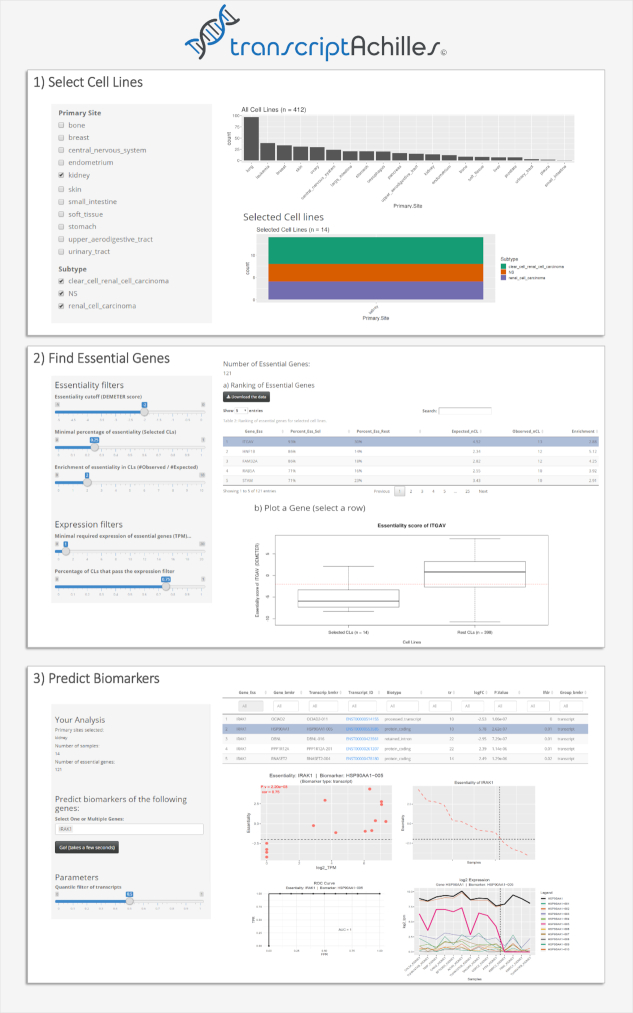
Screenshots of the 3 main tabs of TranscriptAchilles. (1) Selection of cell lines. Both primary site and subtypes can be selected. Two histograms summarize the number of all (up) and selected (down) cell lines. (2) Find Essential Genes. This functionality finds genes whose inhibition reduces the proliferation of the selected cohort. The returned genes are essential, specific, and expressed in the selected cell lines. All the parameters can be tuned with the sliders. A ranking of essential genes and a box plot of essentiality (DEMETER score) for the selected cohort (left) and the rest of cell lines (right) are shown. The red dotted line marks the default essentiality score of –2 dividing the samples into resistant (up) and sensitive (down) to the KD. In this case, the essential gene selected in the ranking table is ITGAV. (3) Predict biomarkers (both transcripts and genes) for the essential genes selected by the user. This analysis can be run for every essential gene in the other tab. The ranking of biomarkers has the following columns: Gene_Ess: essential gene; Gene_bmkr and Transcript_bmkr: gene/transcript expression biomarker; tr: number of transcripts of the corresponding gene; logFC: log2 Fold change of expression; Lfdr: local false discovery rate; Group_bmkr: indicates whether the best biomarker is a gene or a transcript. See legend of Fig. 2 for a more detailed explanation of the plots.